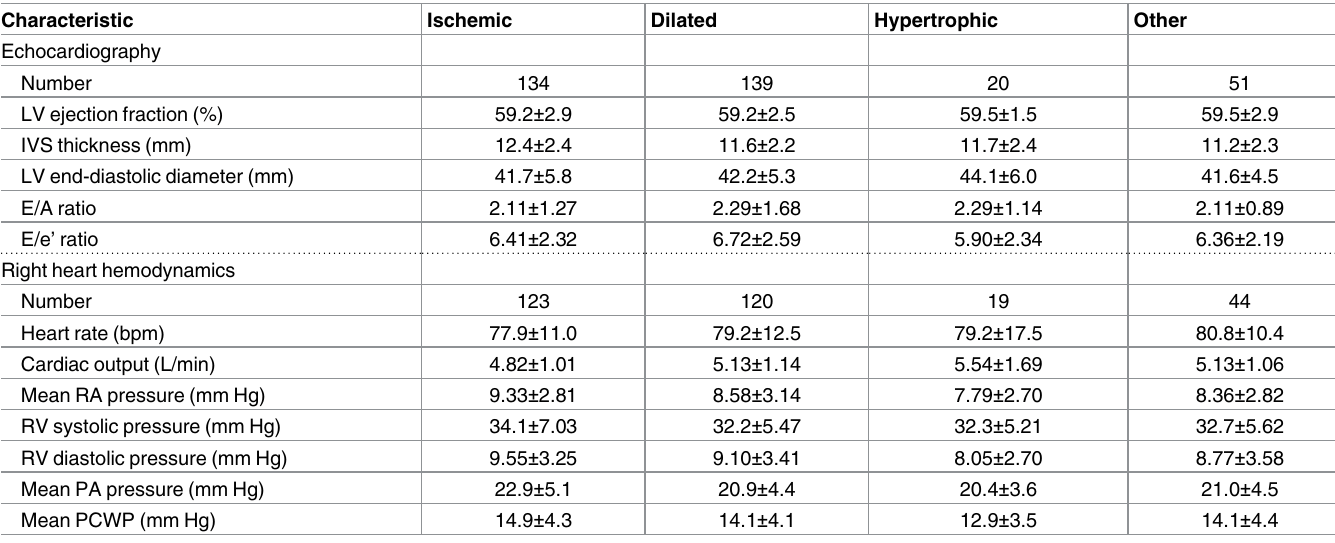
Table 5. Hemodynamic measurements by type of